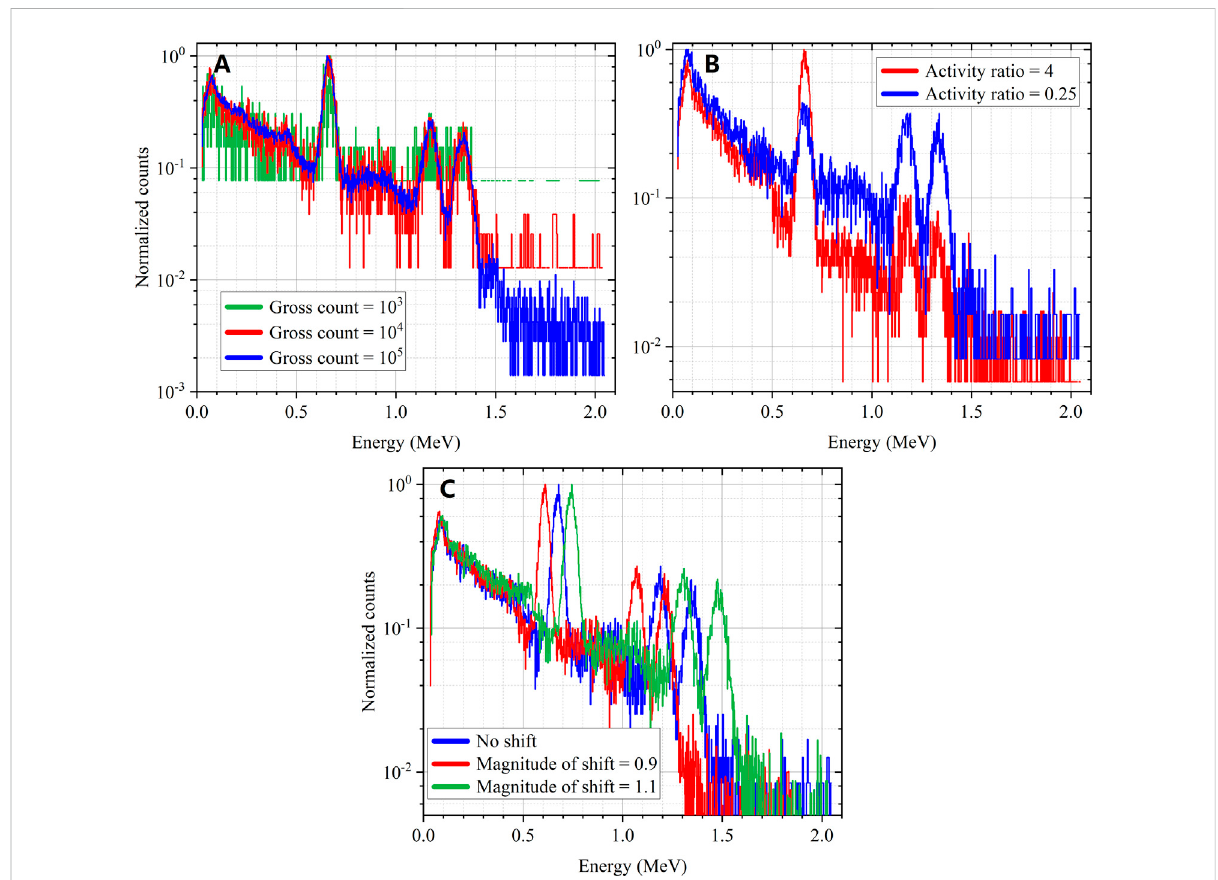
FIGURE 6 Example ofthedataaugmentation; (A) spectrawith differentgrosscounts, (B) spectrawith differentradionuclideactivityratios, (C) spectrawith different magnitude of